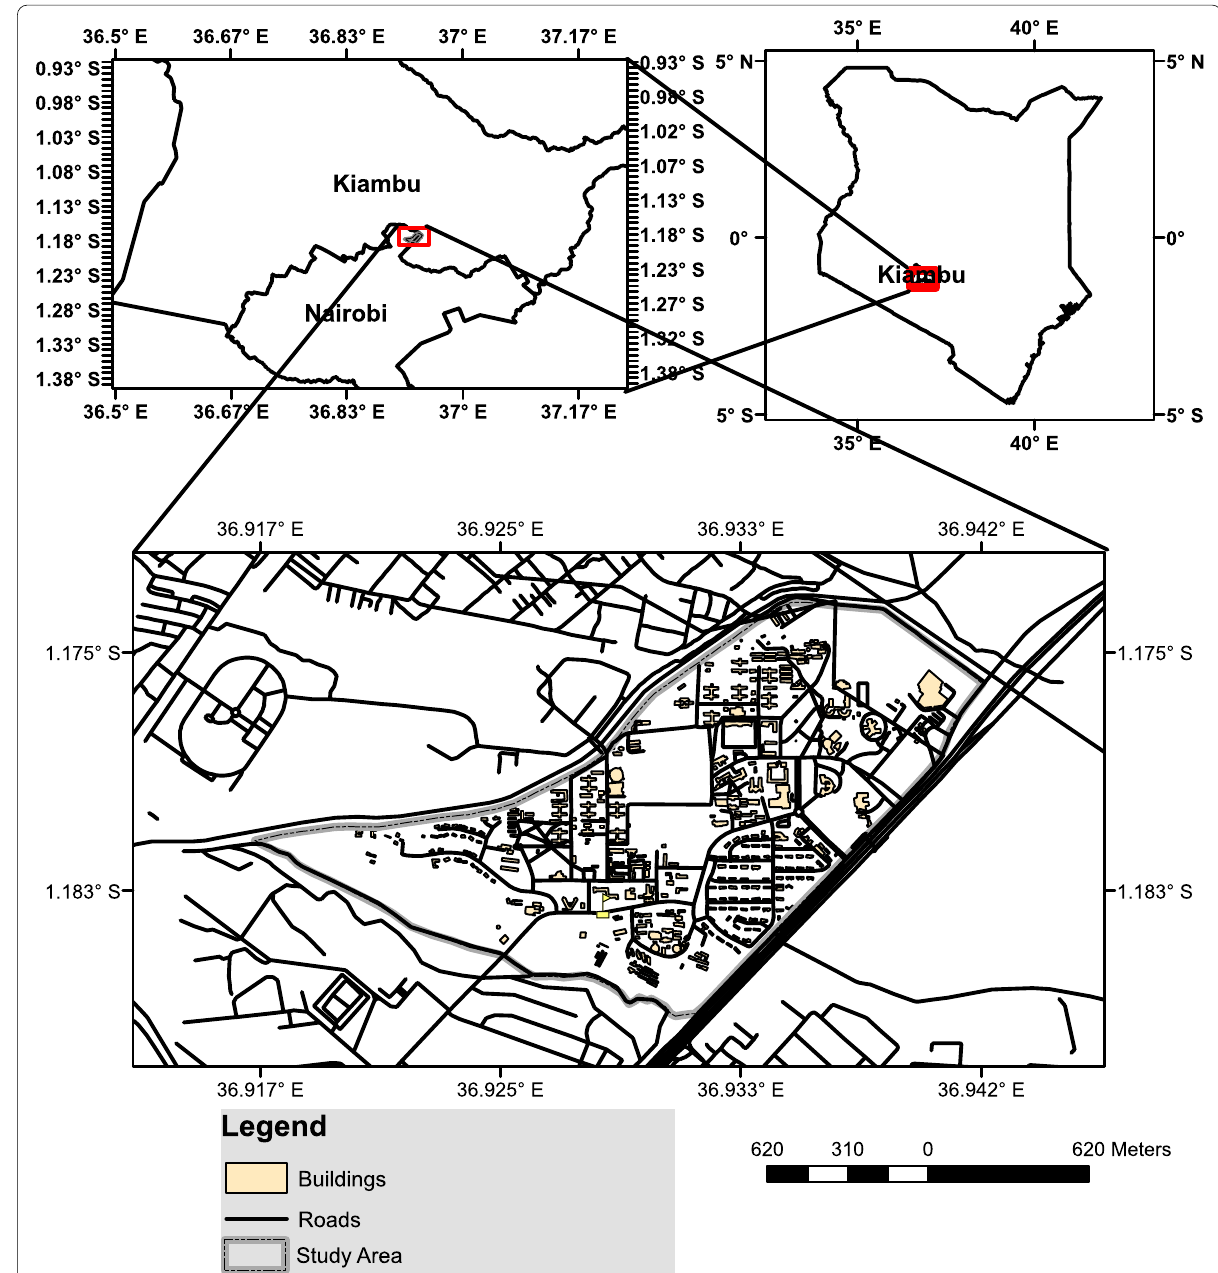
Fig. 1 The study area map showing the road networks downloaded from OpenStreetMap (https:// www. opens treet map. org/) and buildings digitized from Google Earth ®